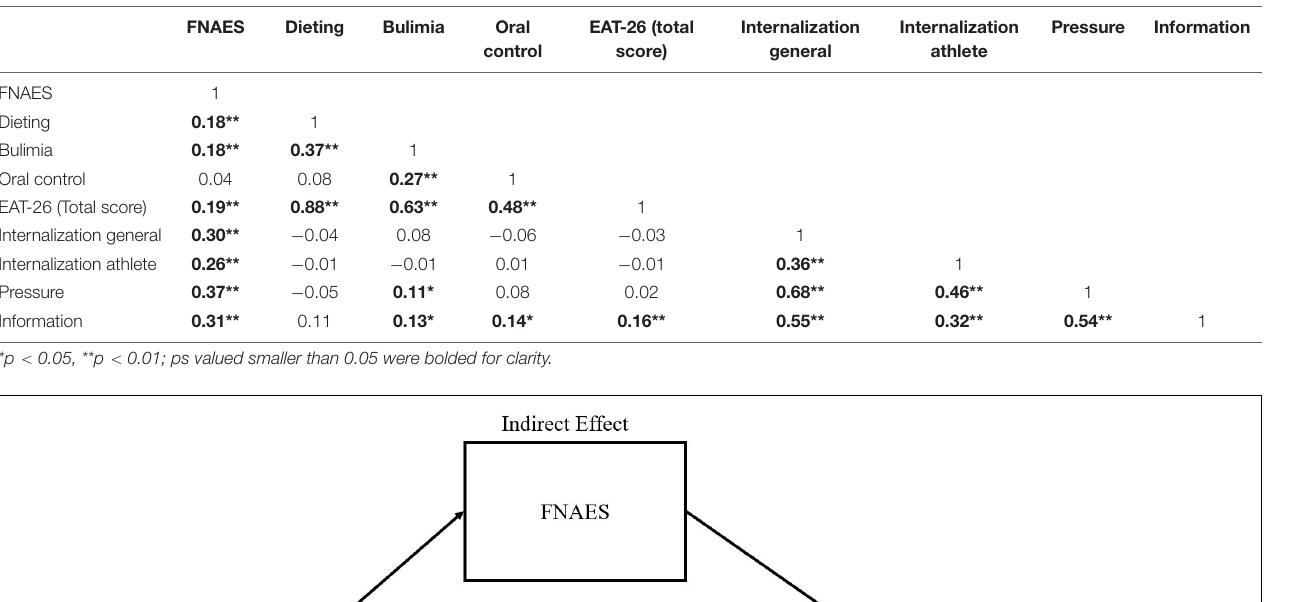
TABLE 2 | Correlation between FNAES, EAT-26, and SATAQ-3 scores.